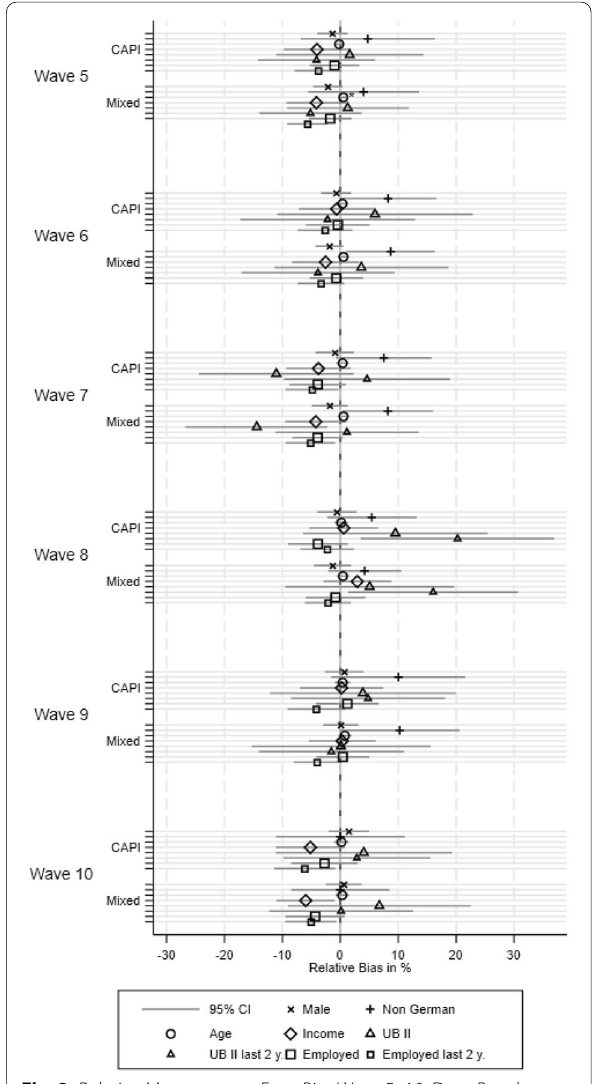
Fig. 2 Relative Measurement Error Bias Wave 5–10. Data: